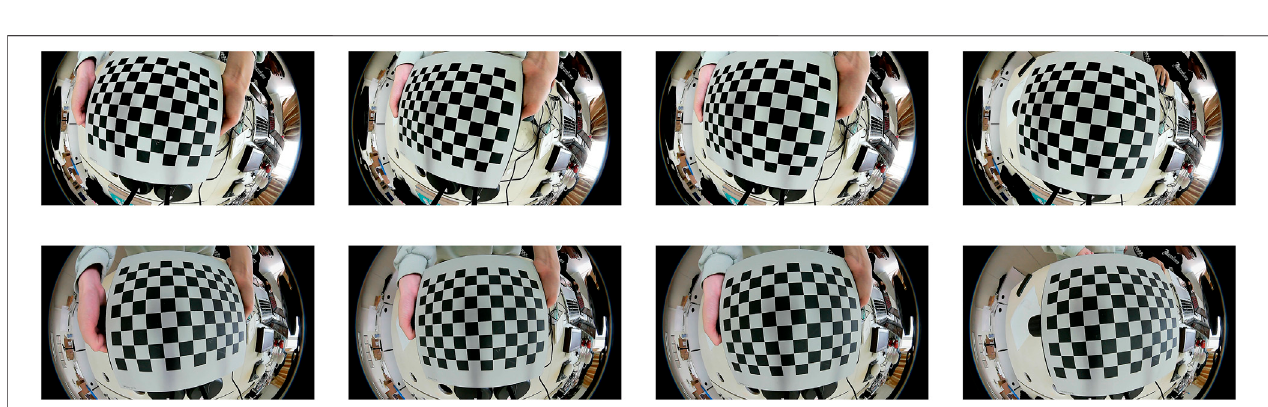
FIGURE 7 | Eight images for conventional stereo calibration. The top four are taken by the left camera; the bottom four are taken by the right camera.